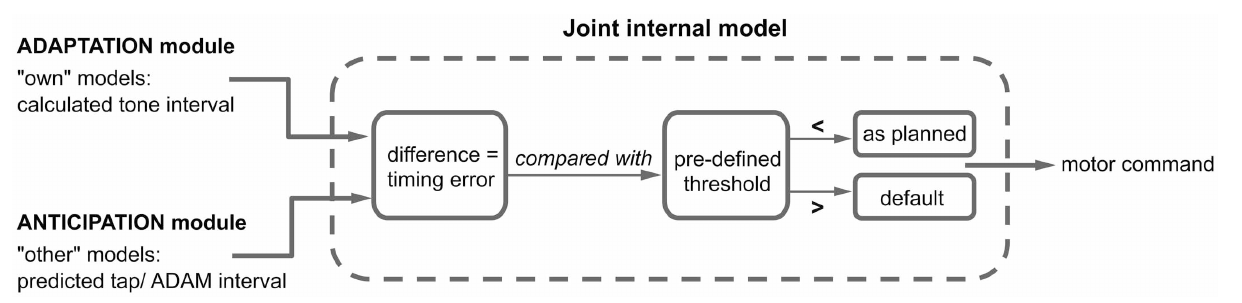
predefined threshold. Depending on this comparison, the motor command is either executed as planned or in accordance with a default setting. A detailed description of this process can be found in the